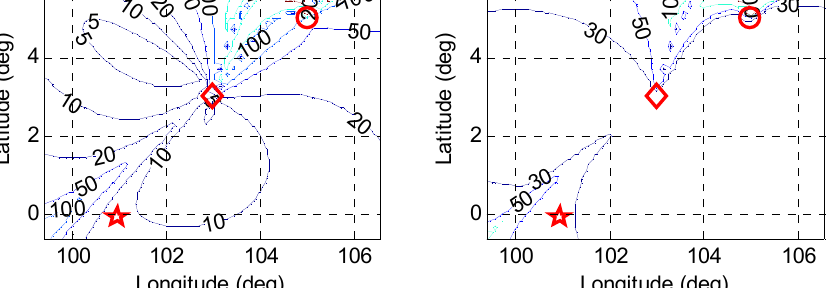
Figure 8. GDOPs of velocity estimation for the scenario of using LEO satellite, airplane and ground station.